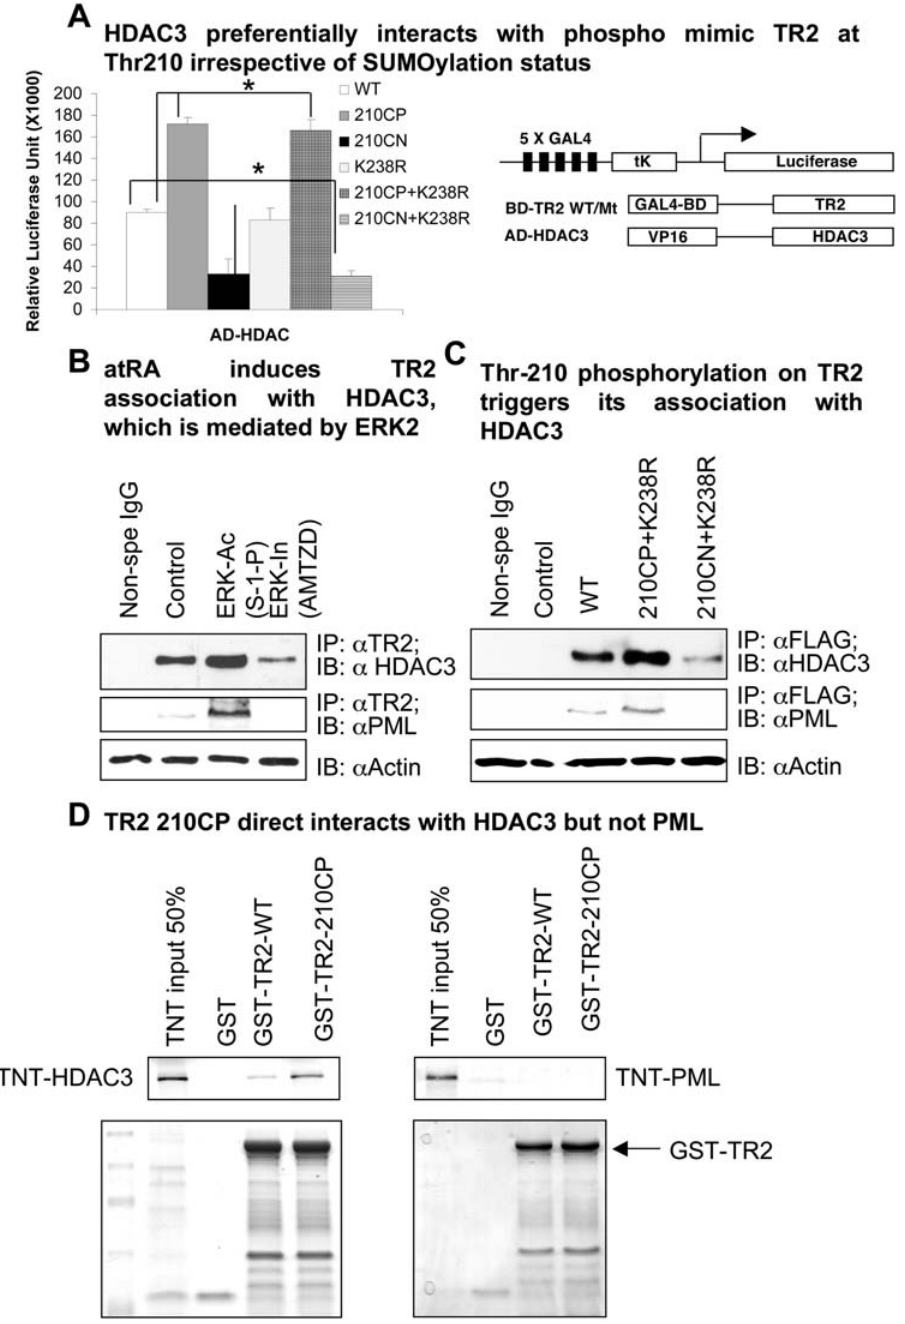
Figure 1. Phosphorylation of Thr-210 but not SUMOylation of Lys-238 enhances association of TR2 with HDAC3. ( A ) Interaction of HDAC3 with TR2 full-length (WT/Mut) constructs. A mammalian version of the two-hybrid system was used to examine in vivo interactions between HDAC3 and TR2 full-length (WT and phospho and/or SUMO Mut) constructs in COS-1 cells. Asterisks denote significant differences (two-tailed Student’s t test; *, P , 0.01). ( B ) The association of endogenous TR2 with HDAC3 in P19 cells was examined in the presence of reagents triggering ERK2 activation (ERK2-Ac) or inhibition (ERK2-In). ( C ) P19 cells were transiently transfected (0.5 m g/ml, 16 h) with FLAG-tagged WT TR2, FLAG-tagged negative SUMOylation mutation in combination with phosphomimetic (210CP + K238R) or negative phosphorylation mutations (210CN + K238R). Association with HDAC3 was examined by coimmunoprecipitation. ( D ) GST pull-down assay of WT/MT TR2 with effectors. Recombinant GST–TR2 WT and Thr-210 phosphomimetic mutant proteins were expressed and purified from E . coli and incubated with 35 S-labeled in vitro -transcribed and translated (TNT) HDAC3 and PML (upper panels). Interacting proteins were resolved by SDS–PAGE and analyzed by autoradiography (upper panels). Half of the TNT protein sample was taken as TNT input (bottom panels). HDAC3 interaction with TR2 was increased when TR2 was phosphorylated at Thr-210 (left panel), whereas PML showed no interaction with WT or phosphomimetic TR2 (right panel).